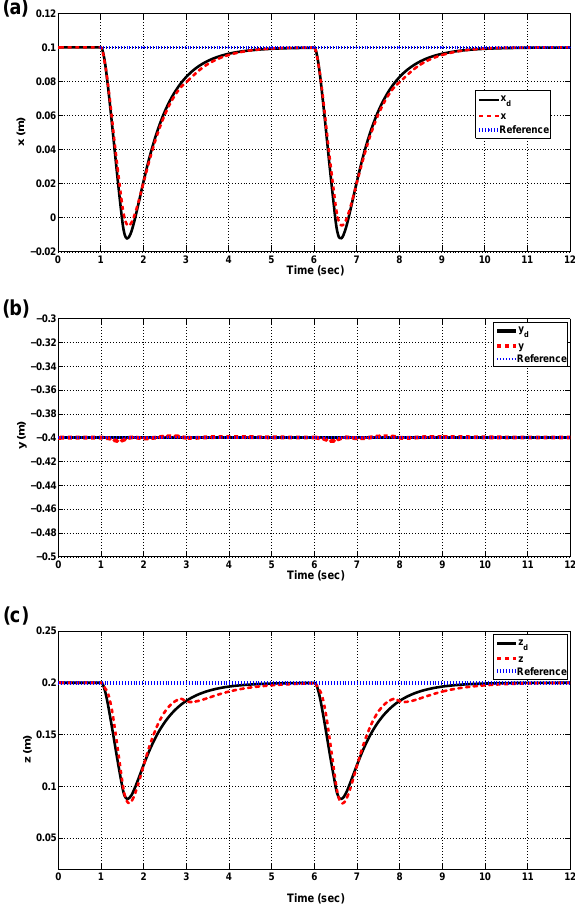
Figure 6. Position x (a) and y (b) and Position errors (c) experi- ment 2).